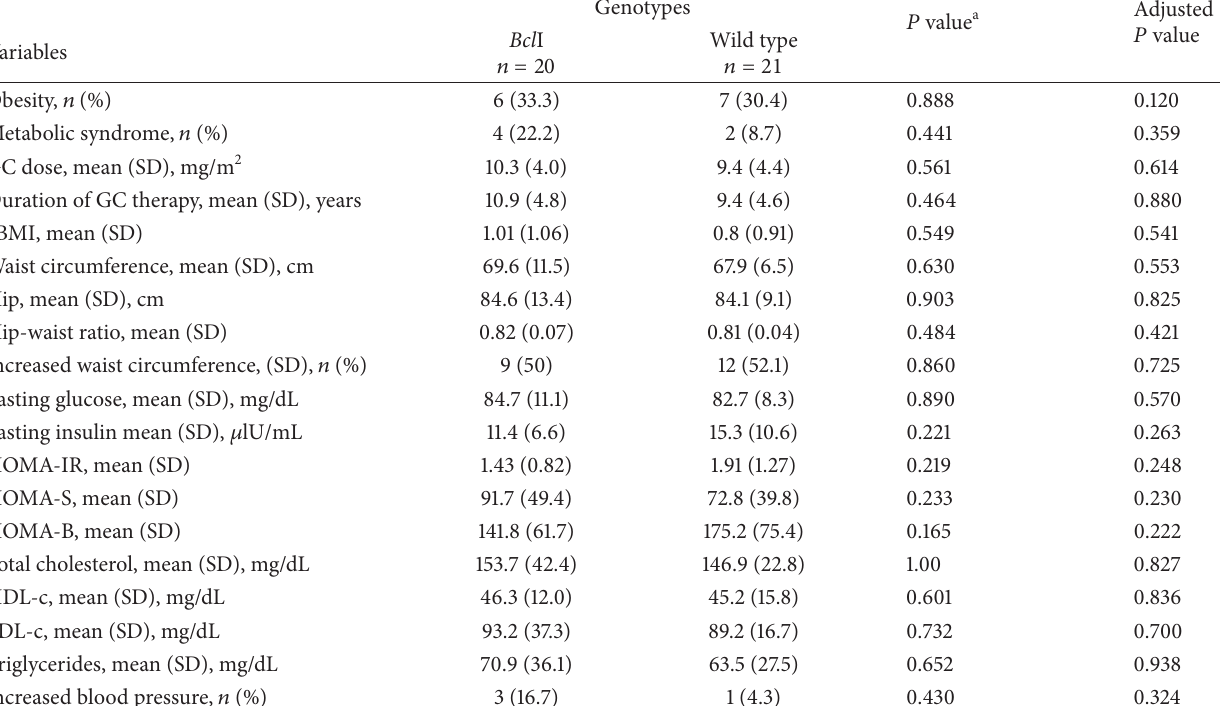
Table 3: Influence of Bcl I polymorphism on the metabolic profile of CAH